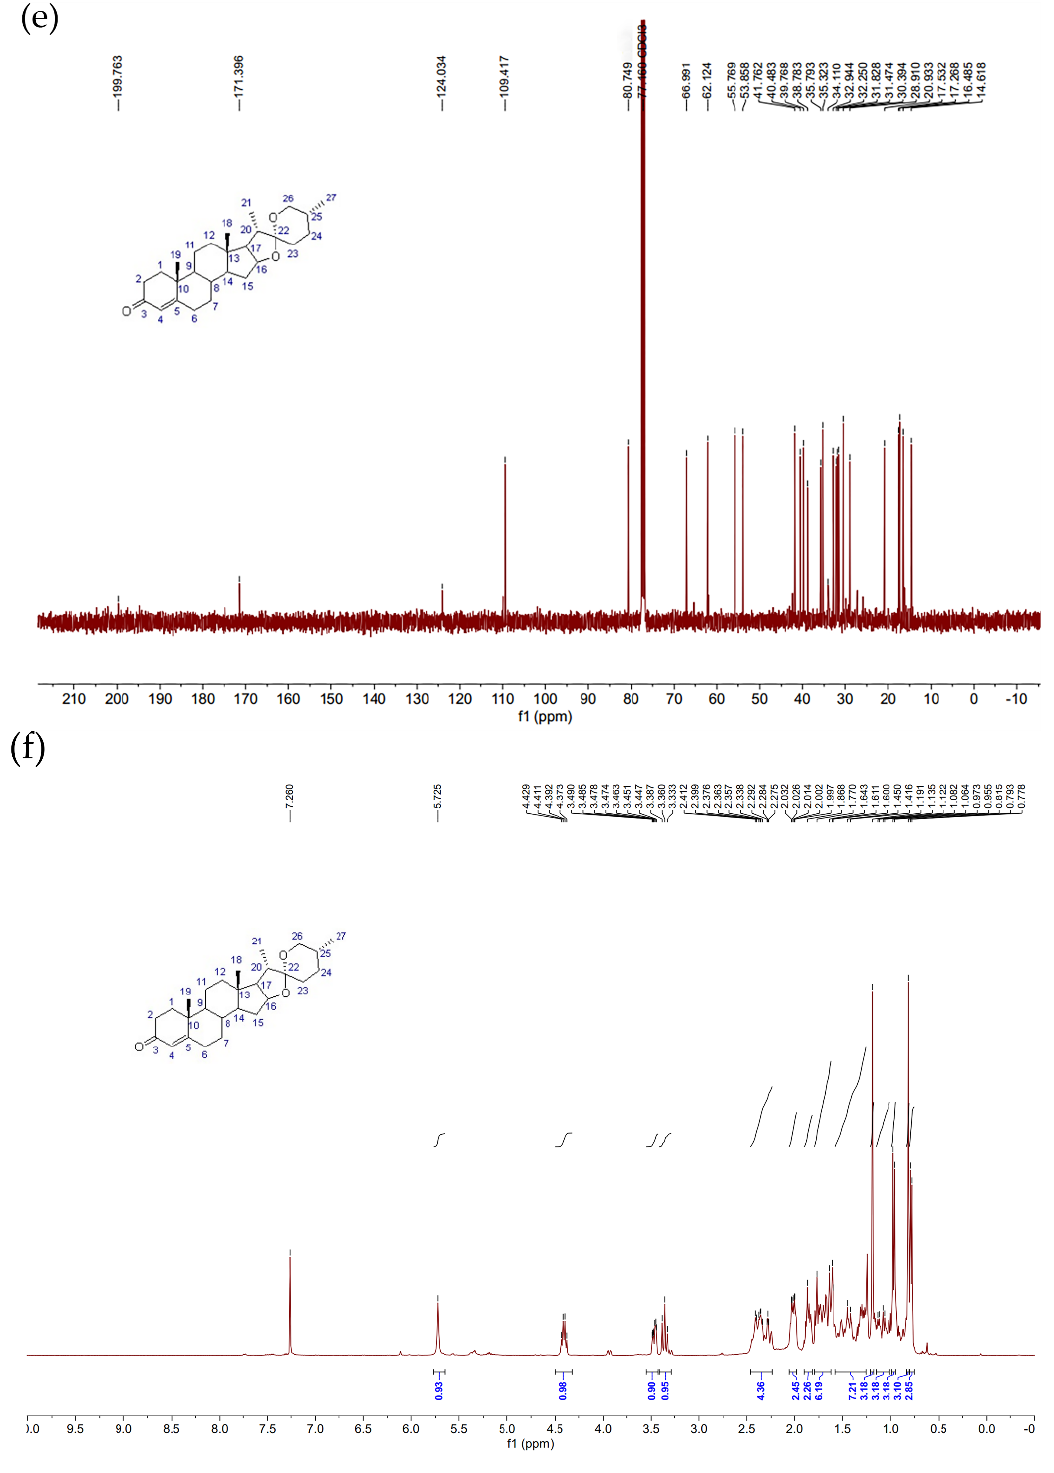
Figure 6. NMR spectra of the three compounds ( a ) diosgenin C-NMR, ( b ) diosgenin 1 H-NMR, ( c ) yuccagenone C-NMR, ( d ) yuccagenone 1 H-NMR, ( e ) diosgenone C-NMR, ( f ) diosgenone 1 H-NMR. The results of our analysis of the above chart are shown in the Table 8.